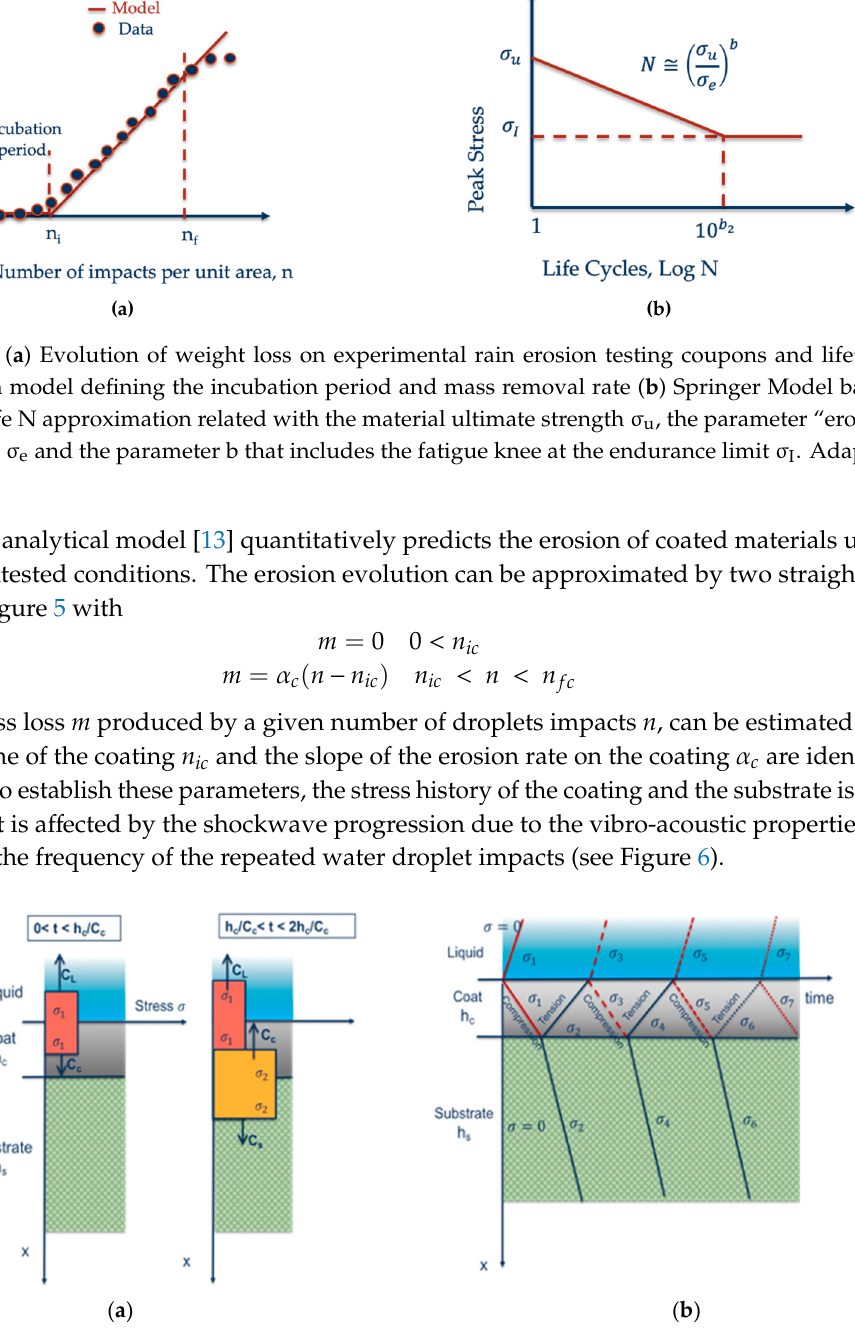
Figure 6. Stress wave pattern in the coating and in the substrate for the time intervals related with coating thickness h c and its wave speed C c.